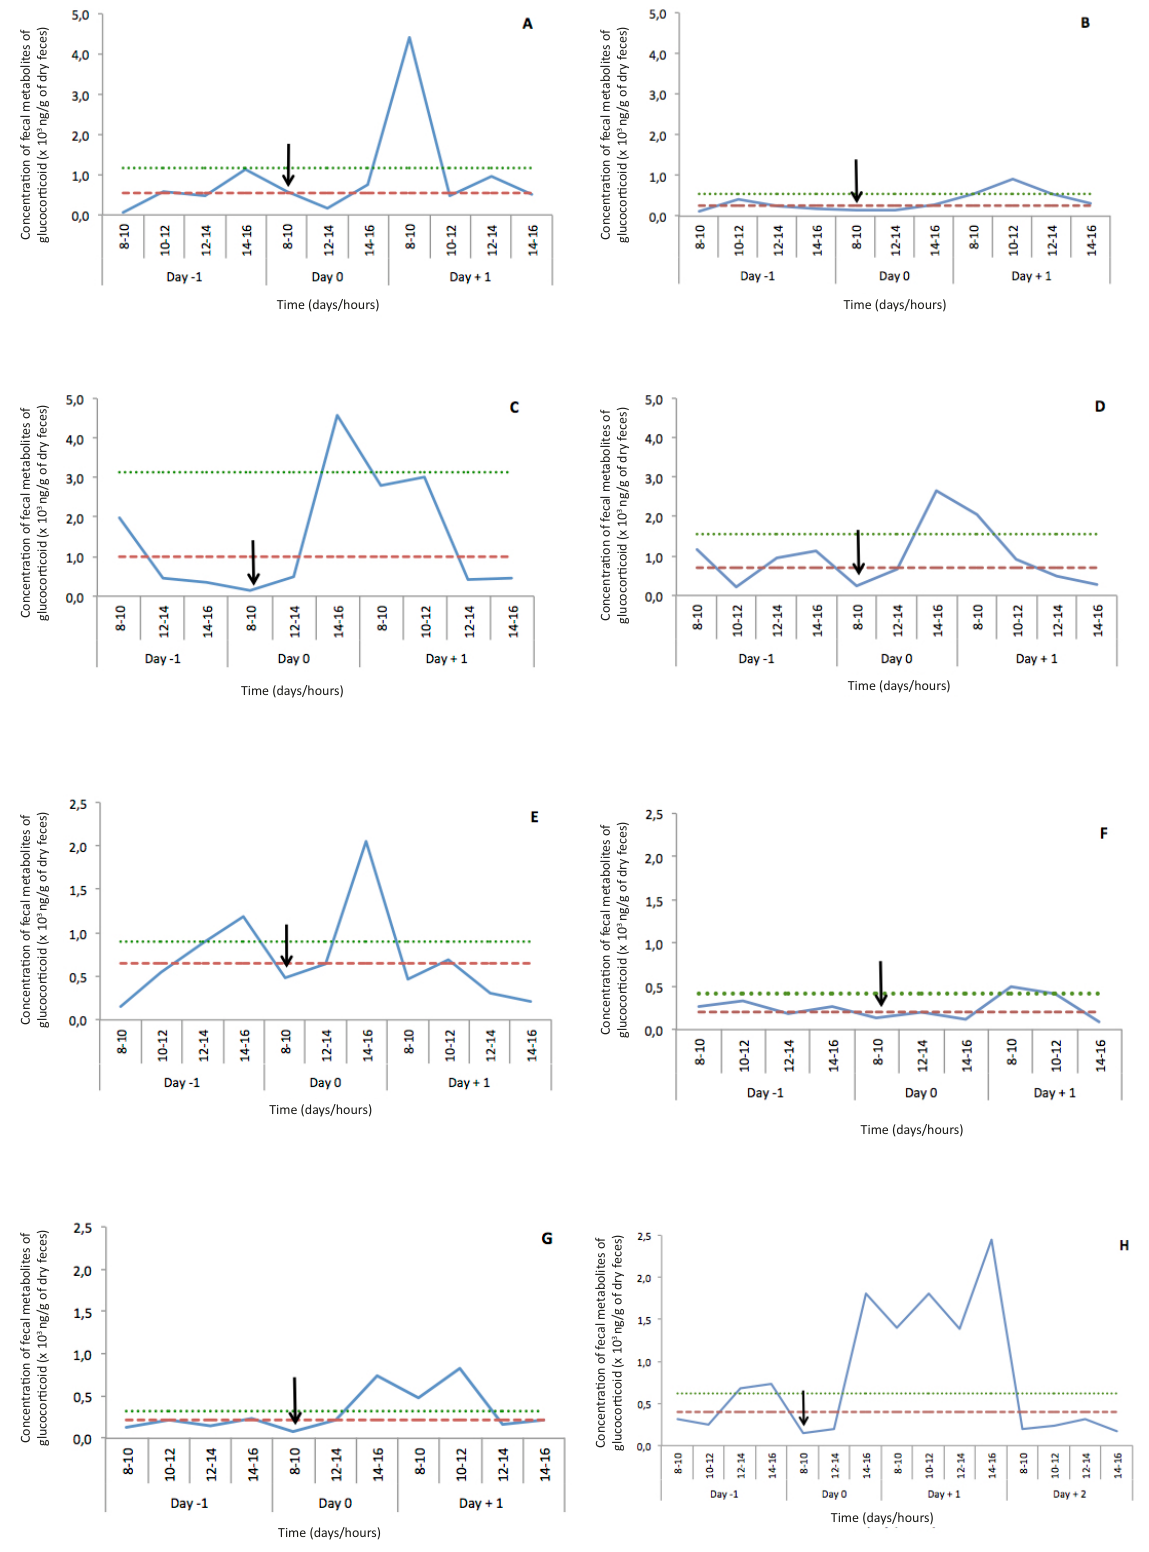
Figure 1. Concentrations of fecal glucocorticoid metabolites in males (A, B, C, D) and females (E, F, G, H) of Callithryx penicillata before and after ACTH injection (arrow); red dashed lines represent basal values; green dashed lines represent peak